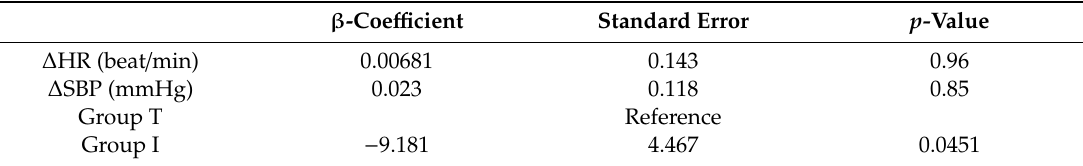
Table 4. Hemodynamic corrected regurgitation volume.